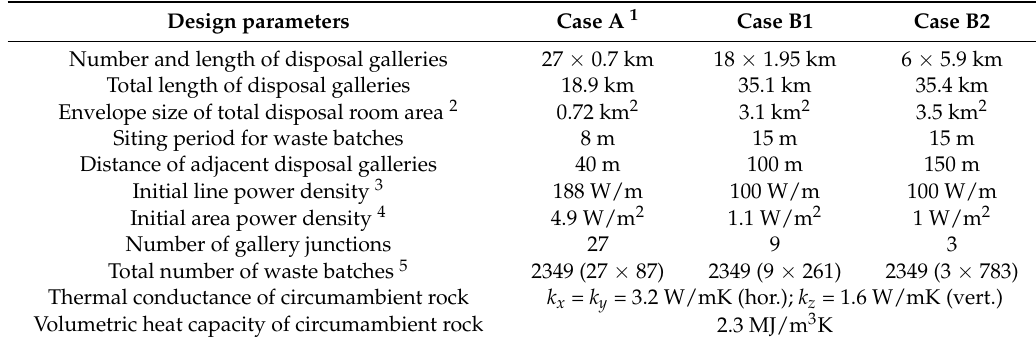
Initial line power density